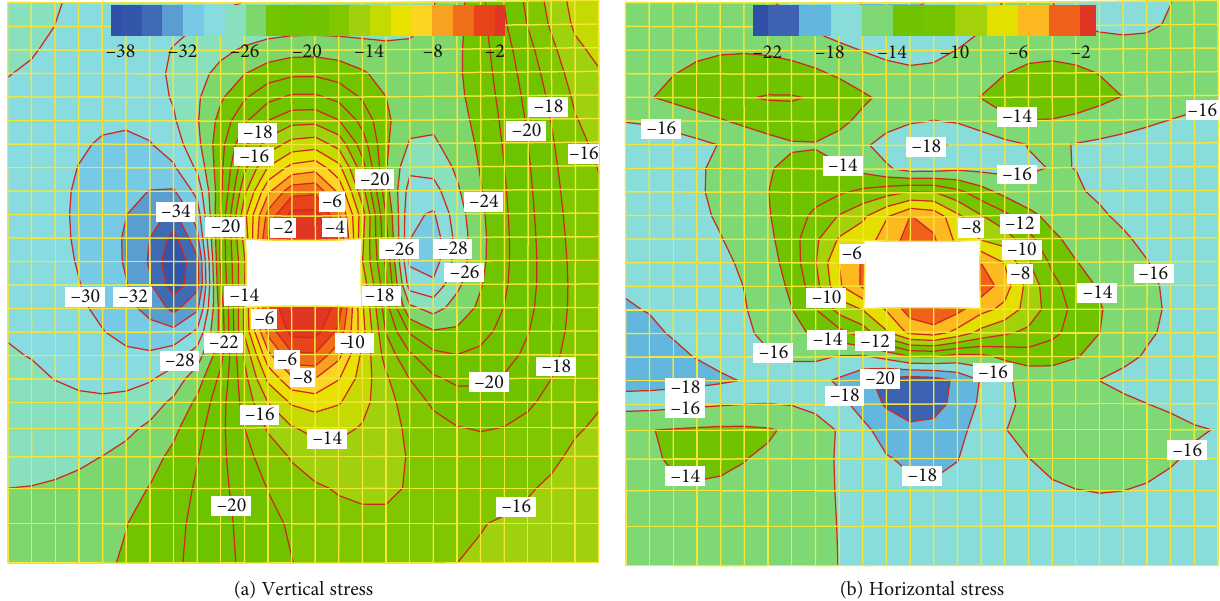
Figure 13: Distribution law of stress fi eld in surrounding rock of roadway after mining.